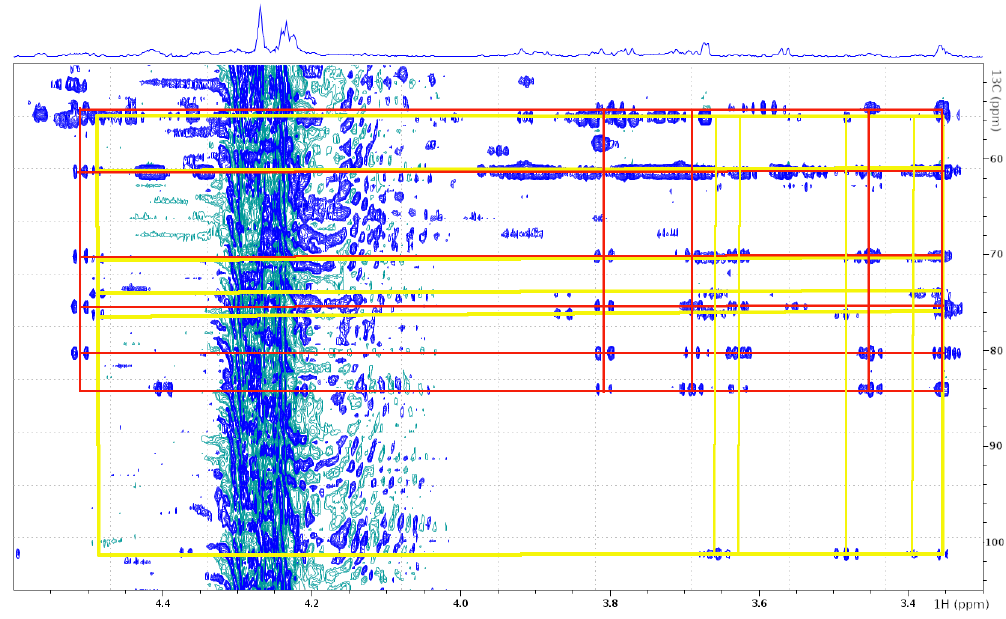
Figure 4. 1 H- 13 C HSQC-TOCSY spectrum (no decoupling) shows internal connectivities of the GlcNAc attached to Ser-18 (yellow) and the GlcNAc attached to Cys-43 (red). Magnetochemistry 2020 , 6 , x FOR PEER REVIEW